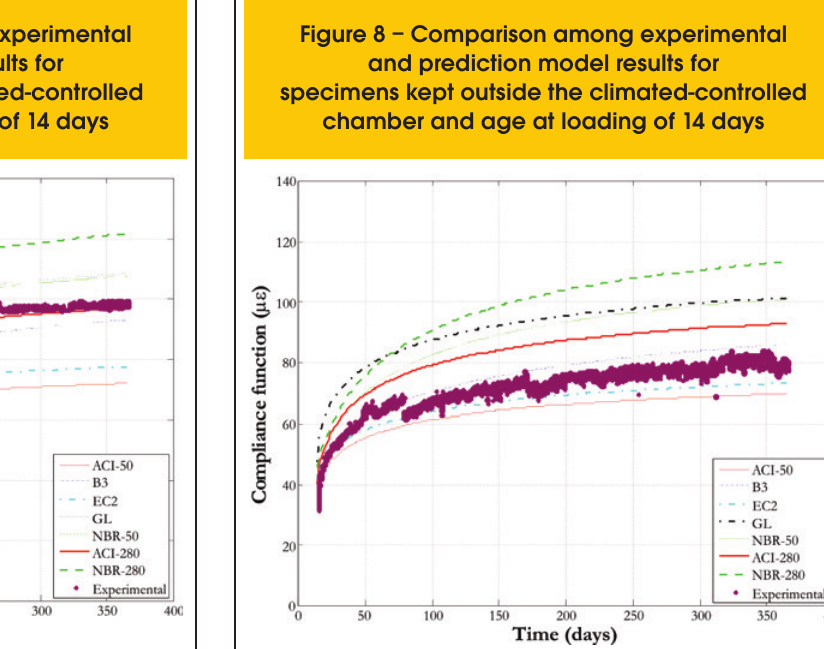
Figure 7 – Comparison among experimental and prediction model results for specimens kept inside the climated-controlled chamber and age at loading of 14 days